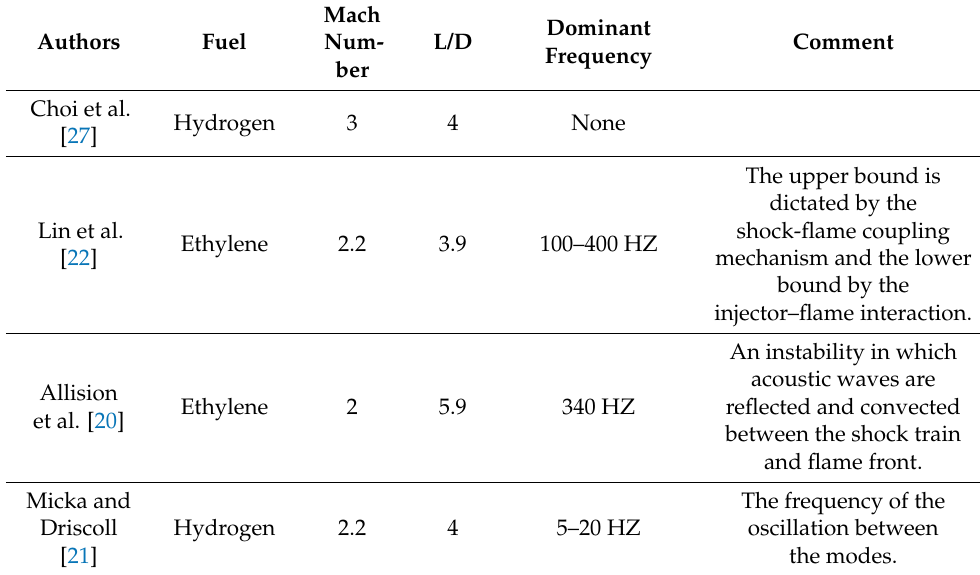
Figure 7. Power spectrum density of FFT for POD mode coefficients, power spectrum of DMD modes for hydrogen injected from K1 injector under Φ = 0.3 together with the first four DMD modes of chemiluminescence images captured by FBE1. Table 3. The oscillation characteristics reported in the literature.